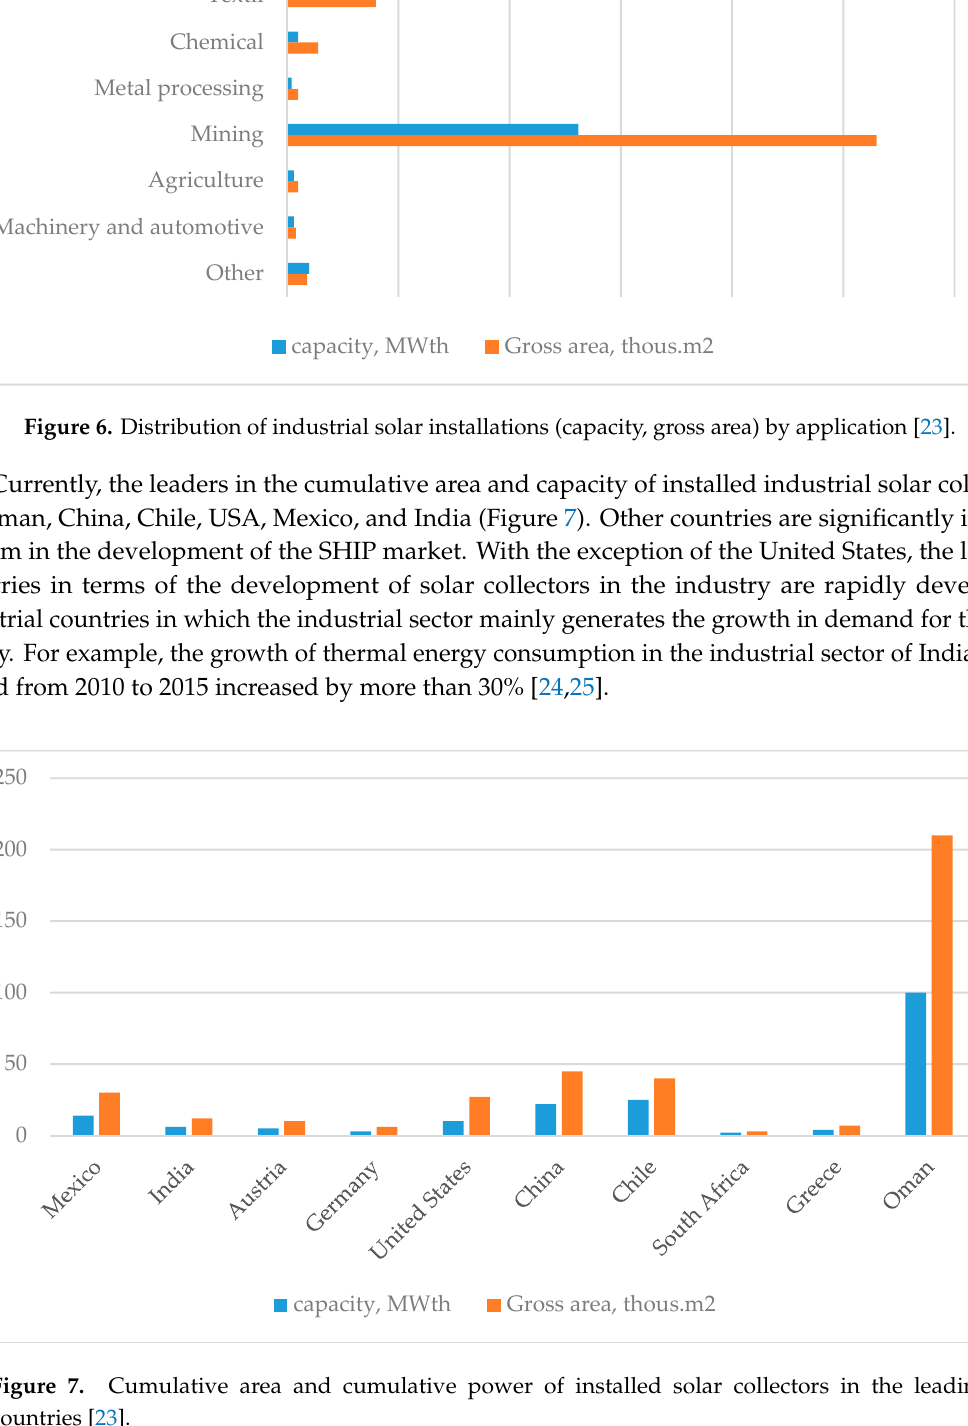
Figure 5. Distribution of industrial solar installations (numbers) by application [23].